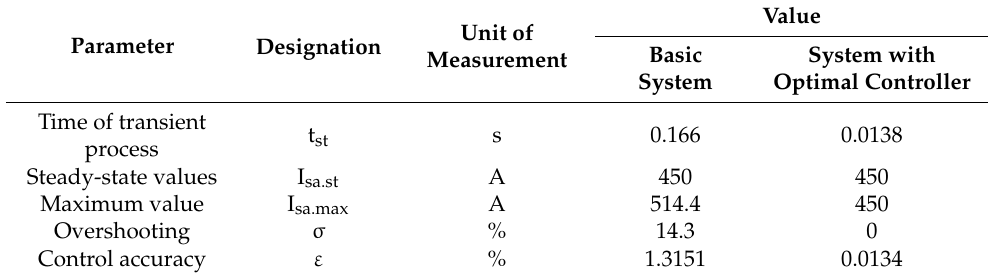
Figure 7. Transient functions: ( a ) under the absence of an interference at the current controller input (of the basic control system (I sa1 ) and system with the optimal current controller (I sa2st )); ( b ) under the presence of an interference at the current controller input (of the basic control system (I sa1 ) and system with the optimal current controller (I sa2st )). Table 3. The results of comparison of the control quality of the basic system versus the system with optimal